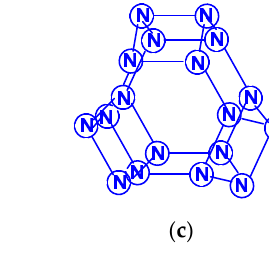
Scheme 15. ( a ): N 18 ( D 3h ); ( b ): N 18 ( C 2v ); ( c ): N 18 ( D 3h ).